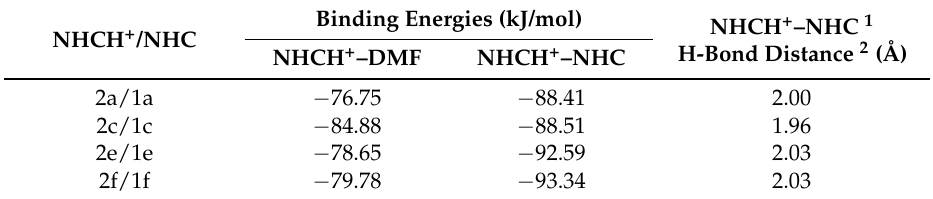
Table 4. NHCH + –DMF and NHCH + –NHC adducts calculated binding energies and H-bond distances. Reproduced with permission from [32]. Copyright Wiley-VCH,